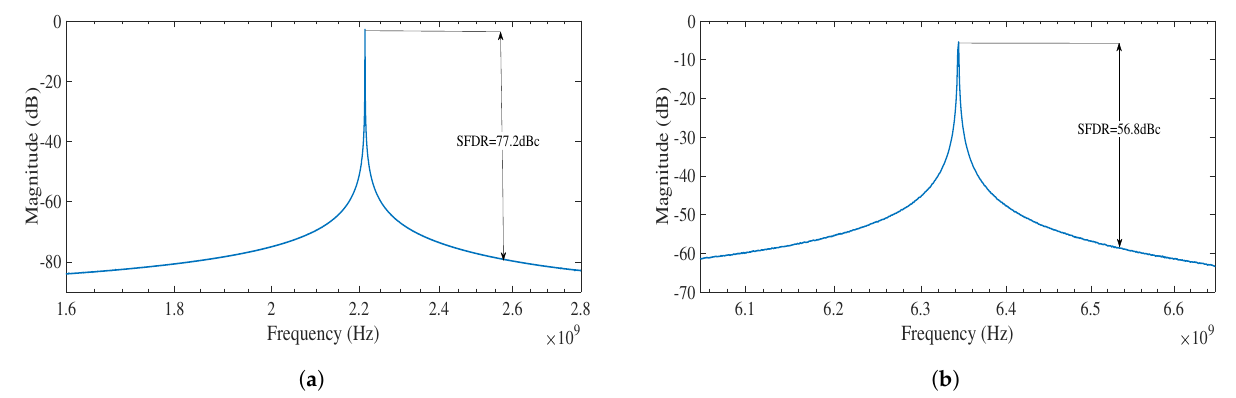
Figure 11. Spectrum of the ( a ) DAC-based DCO at 2.2GHz, ( b ) Controller-based DCO at 6.4GHz. Table 1 shows a comparison with state-of-the-art ADPLL. The DAC-based DCO and controller-based DCO outperform the state-of-the-art designs in terms of area and power consumption. The implemented DAC-based DCO gives an advantage in terms of the resolution and step size of the frequency shifting of the ring oscillator due to the